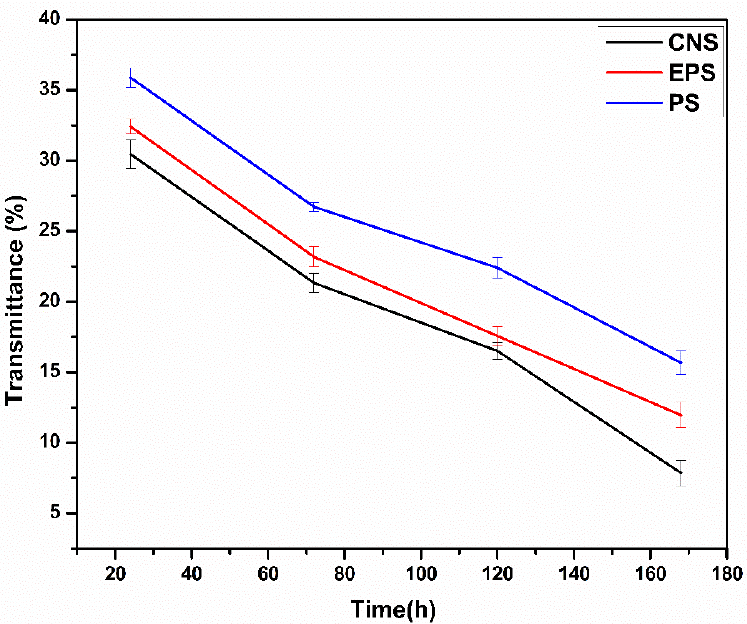
Figure 3. Light transmittance of untreated and CLSs.